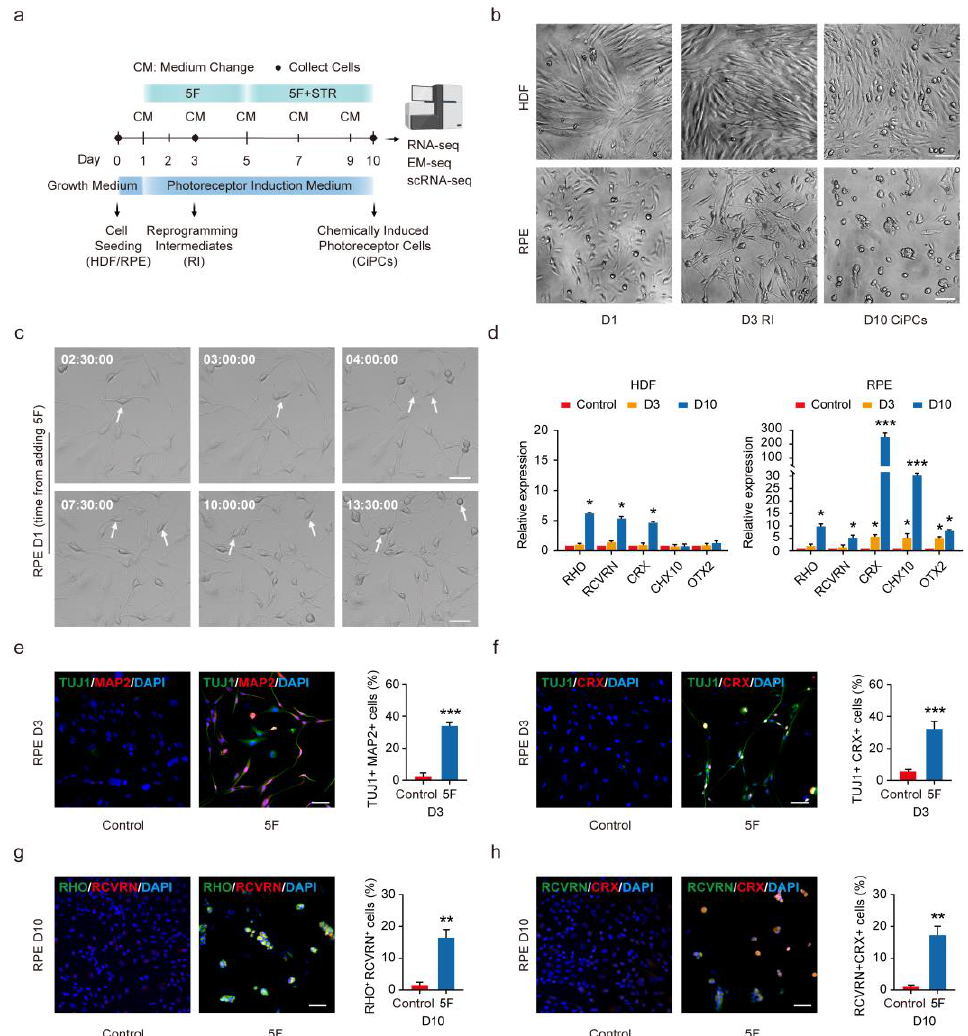
Figure 1. Conversion of HDF and human fetal RPE cells into CiPCs with defined small molecules. ( a ) Schematic of the chemical reprogramming process for CiPCs. 5F, five small molecule factors. STR, sonic hedgehog, taurine, and retinoic acid. ( b ) Bright-field images of HDF- and RPE-derived cells on Day (D) 1, D3 (RI), and D10 (CiPCs). Scale bar: 50 µ m. ( c ) Representative images from live-cell time-lapse imaging show RPE cells undergoing morphological change within the first day after medium change with 5F. Time points were specified within the images. Arrow: typical cells with neural-like morphological change. Scale bar: 50 µ m. ( d ) Relative mRNA expression of photoreceptor markers